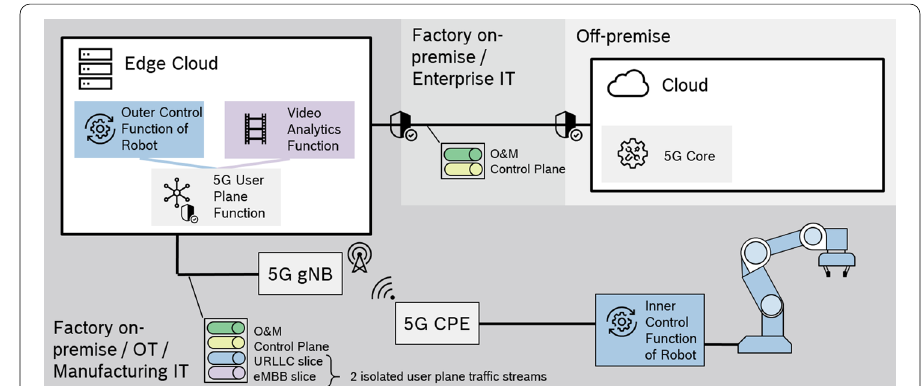
Fig. 4 Implementation of robot platform into factory